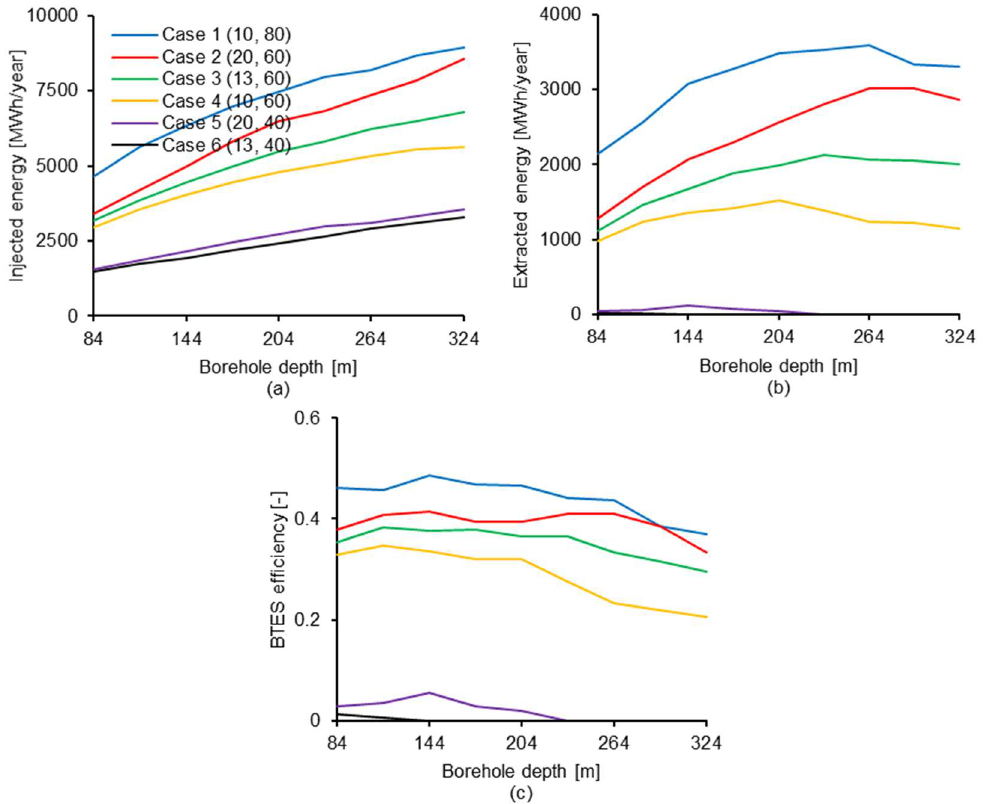
Figure 15. Annual injected energy ( a ), extracted energy ( b ) and BTES efficiency ( c ) as a function of borehole depth. Values given in legend parentheses are the mass flow rate and temperature of the supply flow at heat injection respectively. 144 m is the actual borehole depth.